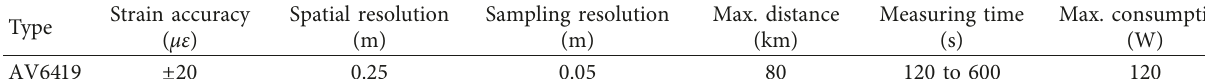
Table 2: Parameters of the demodulator.